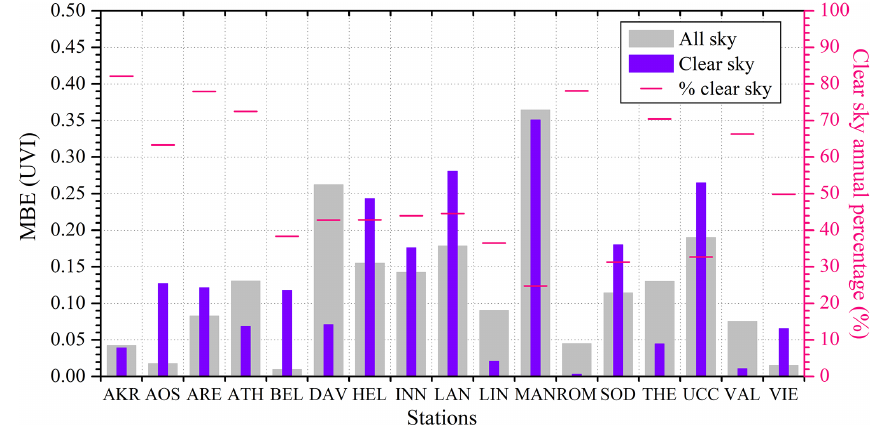
Figure 13. Mean bias error of the modeled UVI as compared to the ground-based measurements for all-sky and clear-sky conditions. The percentage of clear-sky data time steps was also plotted with red